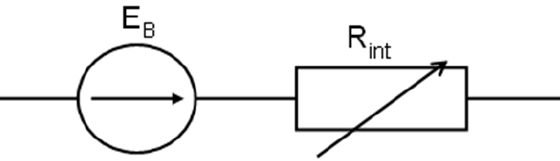
Figure 4. The classic equivalent electrical circuit of the battery.